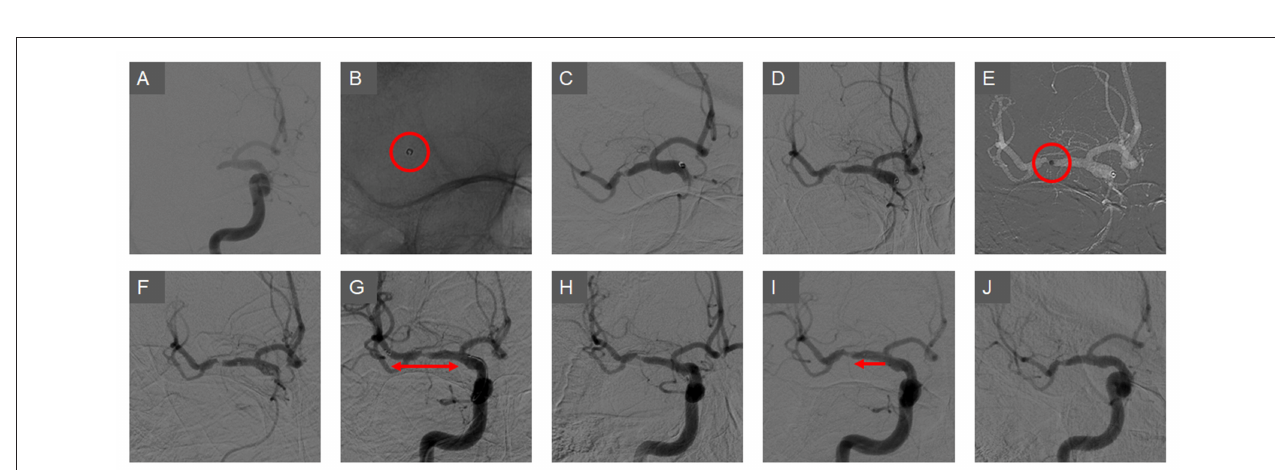
FIGURE 3 | A case of primary use of Solitaire thrombectomy in ICAS-related occlusions. (A) Occlusion is seen in the middle M1 segment of the middle cerebral artery prior to endovascular treatment. (B) The Solitaire stent was deployed for thrombectomy as primary treatment. (C) After the first pass, the clot was removed and partial recanalization was achieved, although focal stenosis was observed. (D,E) After 2 more passes, complete reperfusion was achieved despite the remaining focal stenosis.